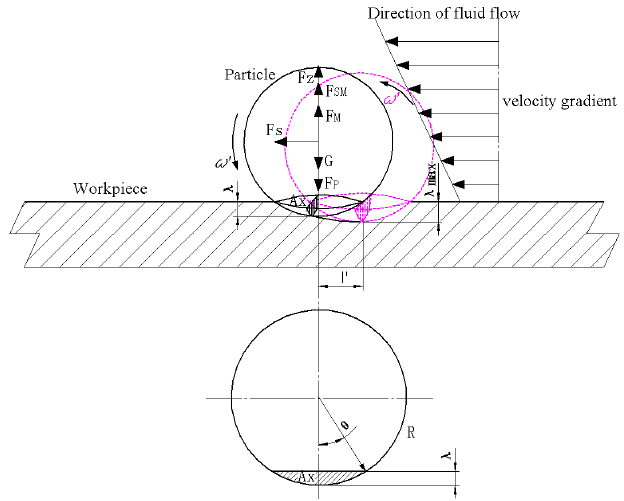
Figure 9. A schematic diagram of the force of abrasive particles during the process from the lowest point of indentation to leaving the workpiece surface.